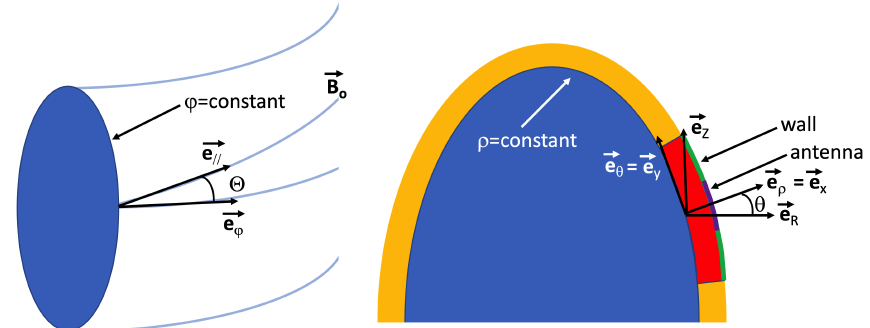
Figure 2. Sketch of the considered geometry. In the slab geometry adopted for the computations, (cid:126) e x = (cid:126) e ρ and (cid:126) e y = (cid:126) e θ . The poloidal middle of the antenna is identified with y